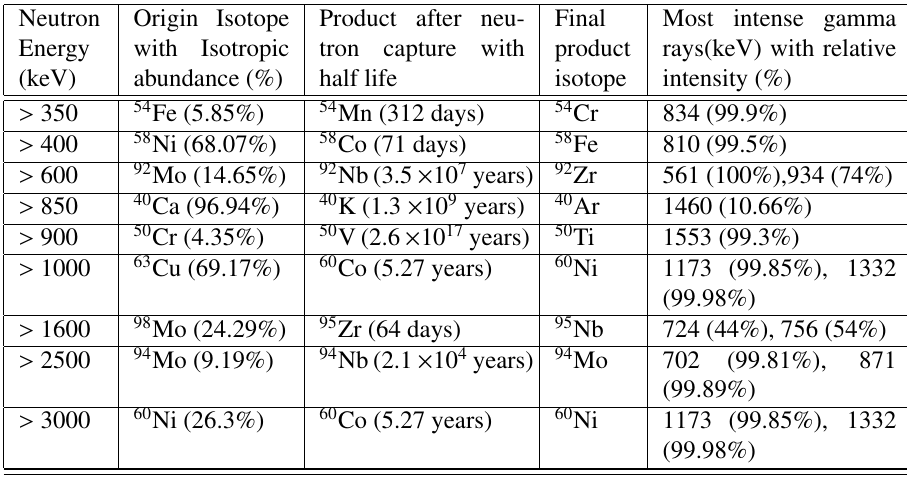
Table 3. Contribution of di ff erent isotopes due to increase in neutron energy. Isotopes in the vicinity and their natural abundance, produced isotopes after neutron capture and their half lives are listed in Columns 2 and 3. Column 4 and 5 indicated the final product and their most intense gamma rays along with relative intensity. Gamma energies and relative intensity are taken from NNDC